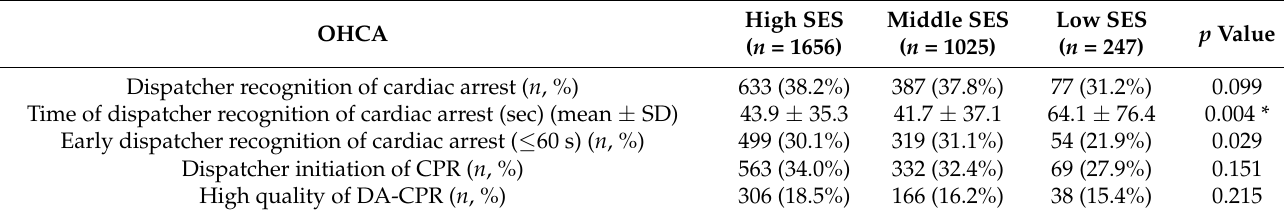
Table 2. Performance of dispatcher-assisted cardiopulmonary resuscitation by community socioeconomic status. High SES OHCA